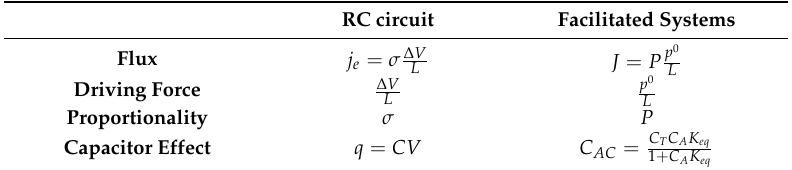
Table 1. Analogies between electrons transport and mass transport in resistor–capacitor circuits (RC) parallel circuit and facilitated transport systems with fixed sites carrier [112].